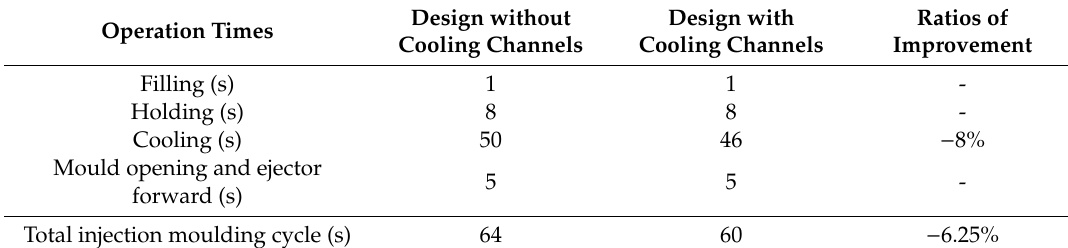
Table 5. Information about operation times and their ratios of improvement of the initial inserts design (without cooling channels) and the re-design (with cooling